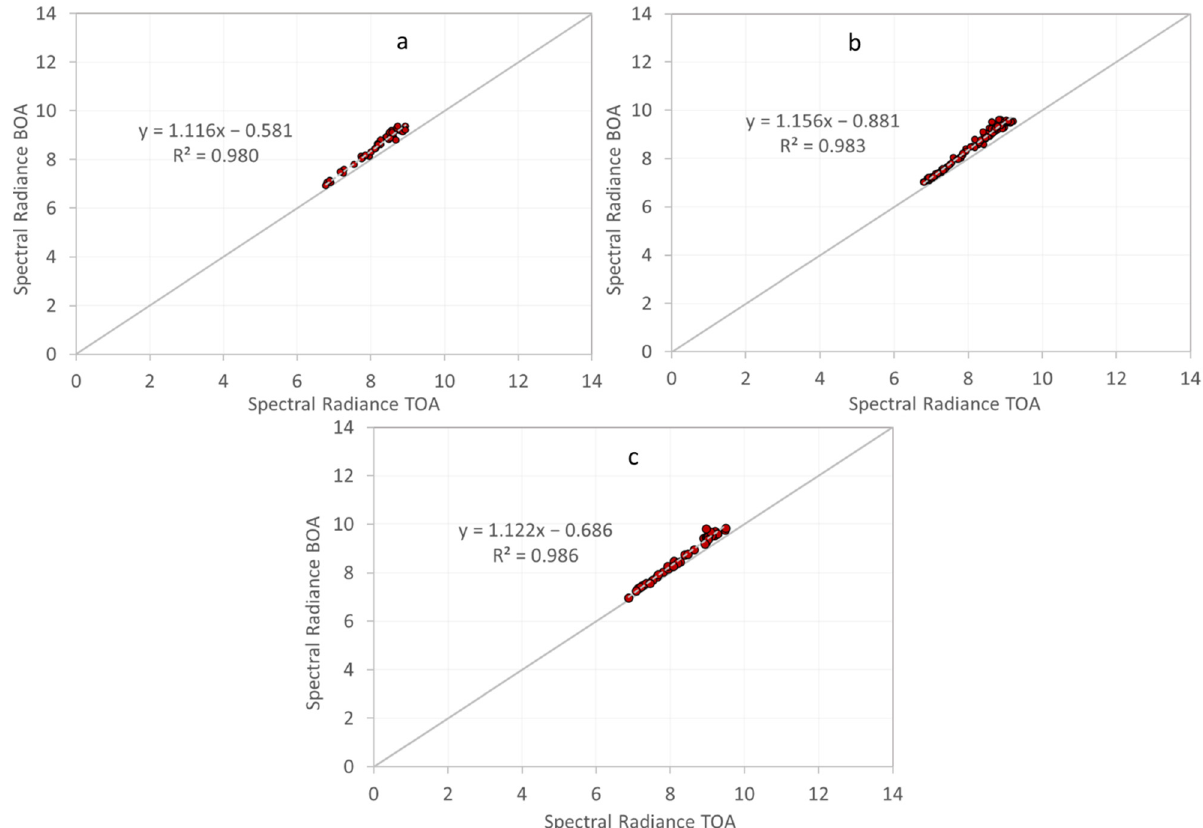
Figure 2. Linear regression between spectral radiance BOA and TOA for Landsat-5 ( a ), Landsat-7 ( b ) and Landsat-8 data ( c ).